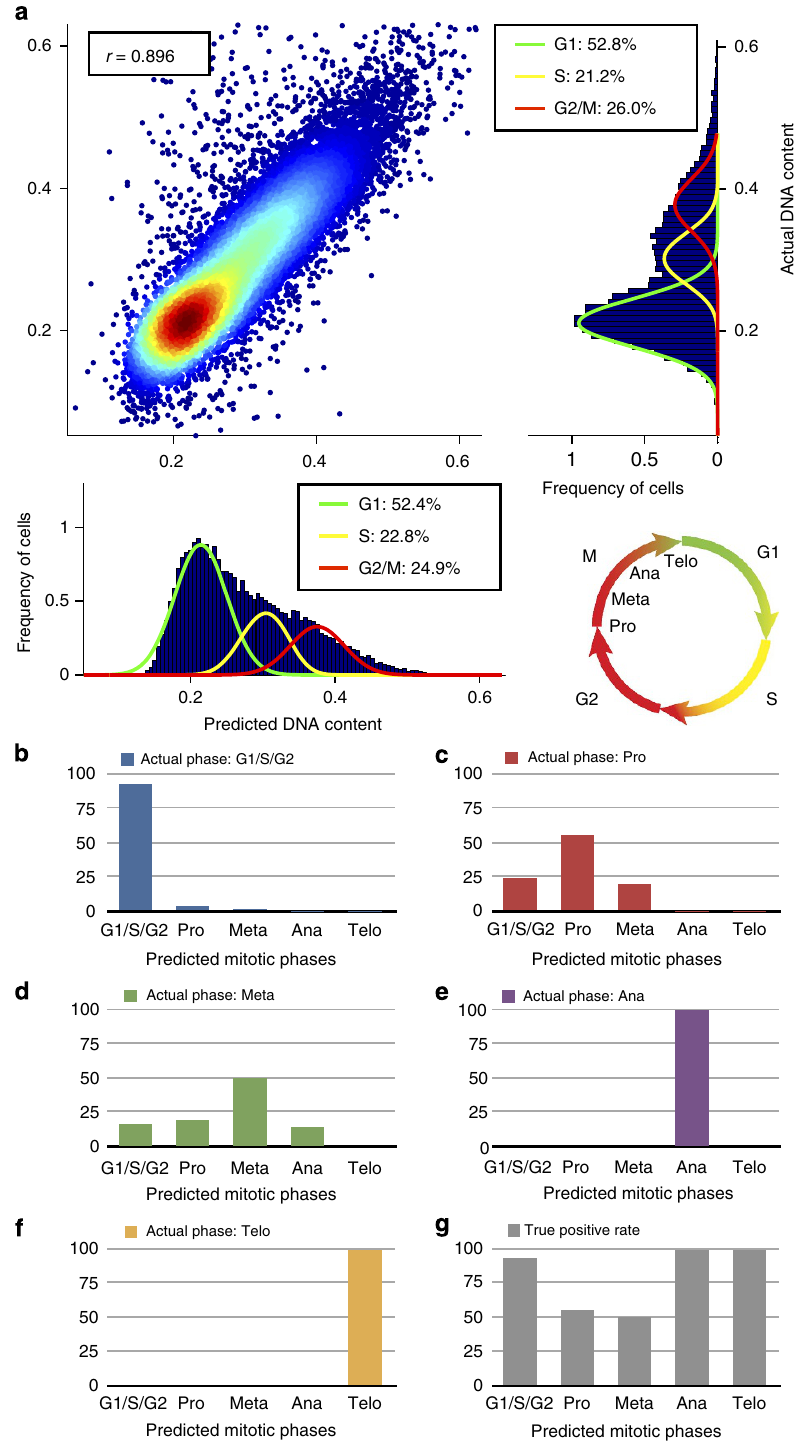
Figure 2 | Machine learning allows for robust label-free prediction of DNA content and cell cycle phases of Jurkat cells. ( a ) We find a Pearson’s correlation of r ¼ 0.896 ± 0.007 (error bars indicate the s.d. obtained via 10-fold cross-validation) between actual DNA content and predicted DNA content based on regression using brightfield and darkfield morphological features only (see Methods section). We used the Watson pragmatic curve fitting algorithm to specify the fraction of cells in the G1, S and G2 phases. ( b – f ) For cells that are actually in a particular phase (for example, b shows cells in G1/S/G2), the bar plots show the classification results based on brightfield and darkfield morphological features only (for example, b shows that the few cells in prophase (Pro), metaphase (Meta), anaphase (Ana), and telophase (Telo) are errors). ( g ) Bar plot of the true positive rates of the cell cycle